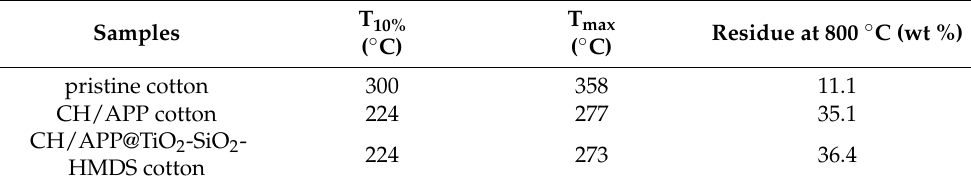
Figure 4. The TGA ( a ) and DTG curves ( b ) of the pristine cotton, CH/APP cotton, and CH/APP@TiO 2 -SiO 2 -HMDS cotton under nitrogen. Table 2. TGA and DTG curves characteristic parameters for cotton